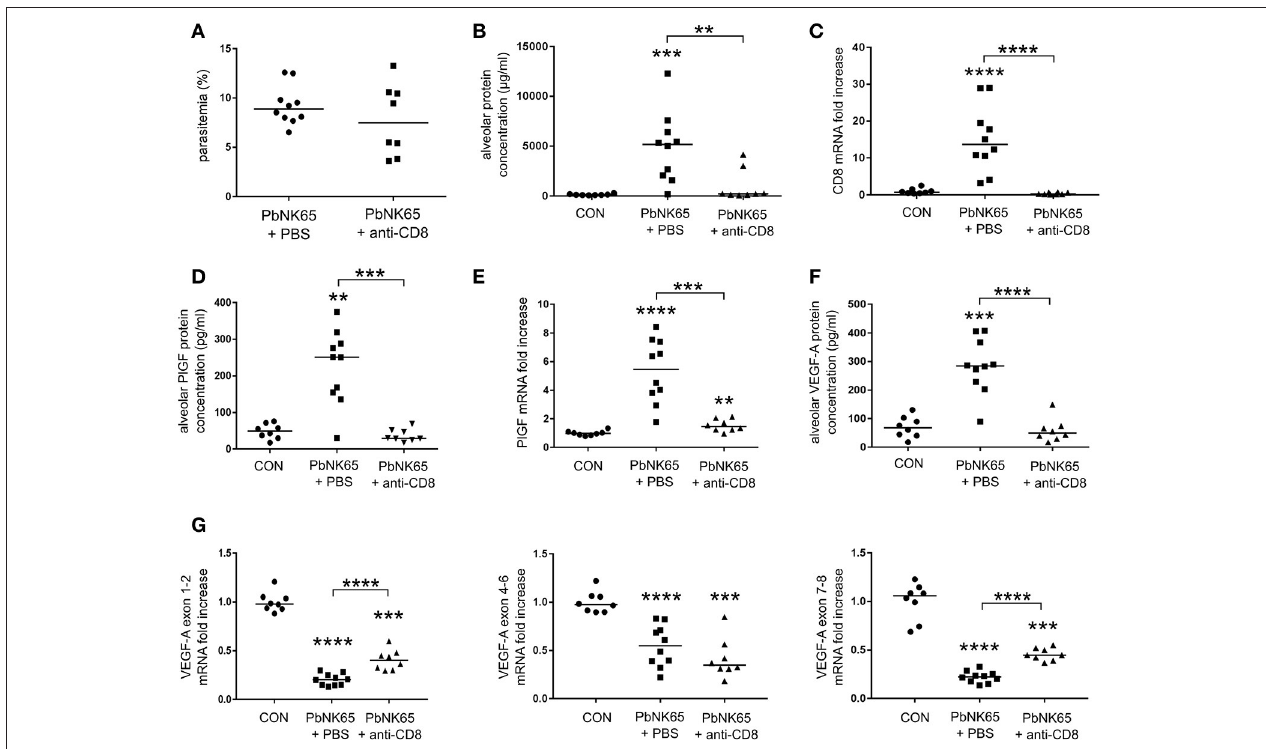
FIGURE 4 | Alveolar edema and expression of VEGF-A and PlGF are dependent on pathogenic CD8 + T cells. C57BL/6 mice were infected with PbNK65 and treated with anti-CD8 β antibodies to deplete CD8 + T cells. The effect of the depletion on (A) peripheral parasitemia and (B) alveolar edema was determined. (C) Quantitative RT-PCR for CD8 indicated the efficacy of the depletion. (D,F) The alveolar protein levels of PlGF and VEGF-A and (E,G) pulmonary mRNA expression of PlGF and of the different VEGF-A isoforms were compared between CD8 + T-cell depleted and mock-treated animals. Compilation of two experiments, n = 8–10 per group.